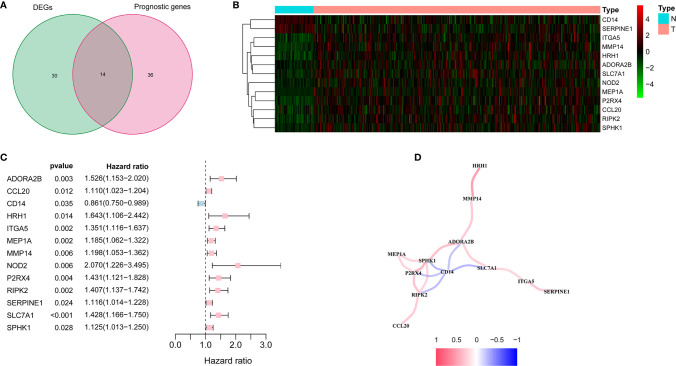
Identification of the candidate inflammatory response-related genes in the TCGA cohort. (A) Venn diagram to identify DEGs between HCC tissues and adjacent normal tissues. (B) The 13 overlapping genes expression between HCC tissues and adjacent normal tissues. (C) Forest plots showing the results of the association between 13 overlapping gene expression and OS. (D) The correlation network of candidate genes.